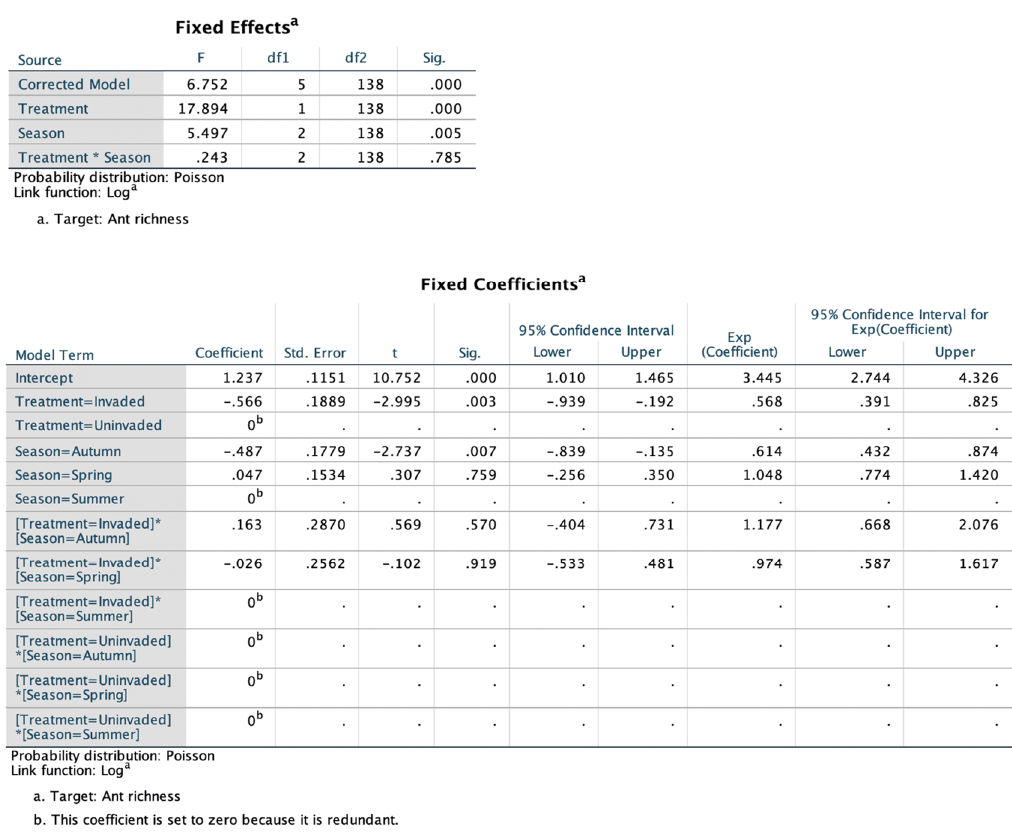
Figure A2. Results for the generalized linear mixed model (GLMM) of ant richness fitted by the Poisson distribution, with treatment, season and their interaction as fixed factors, the orchards as subjects with repeated measures and the year as a random variable.